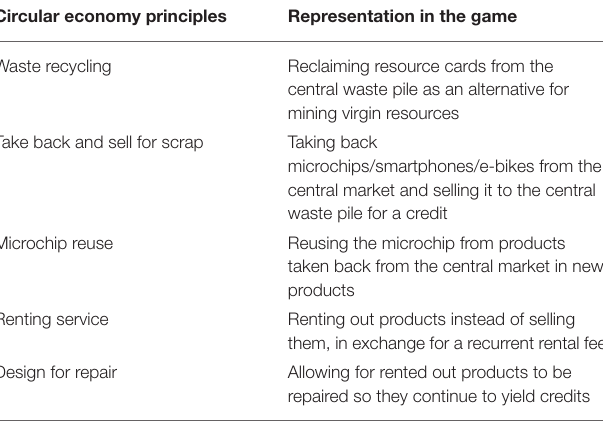
TABLE 3 | Circular economy strategies in the ecoCEO game.